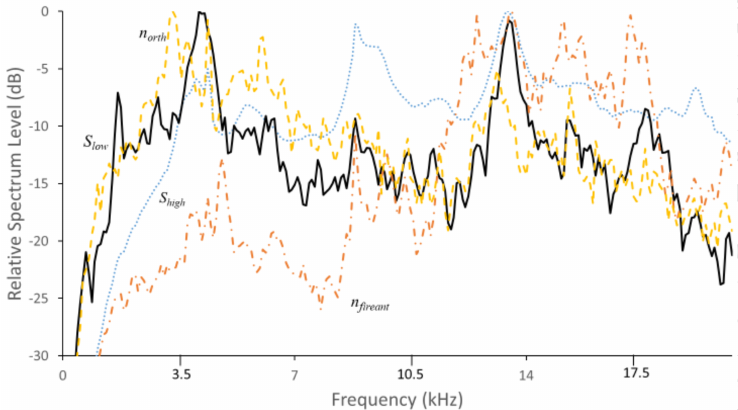
Figure 2. Mean spectra of: S high signals (dotted line) and S low signals (solid line) identified as substrate vibrations of potential subterranean insects in grape root systems; n fireant signals (dot dashed line) identified from fire ants; and n orth signals (dashed line) identified from crickets or